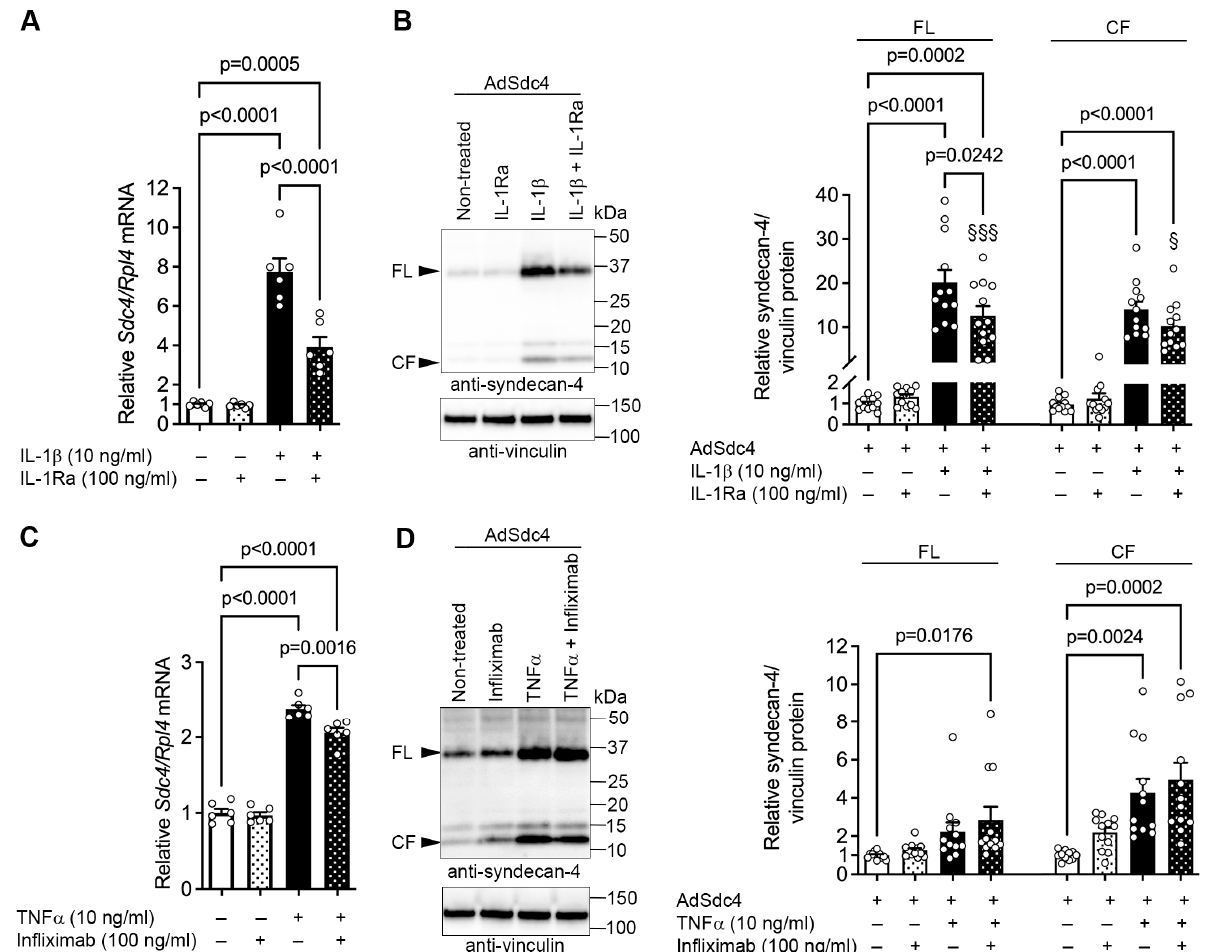
Figure 5. Interleukin 1 β -increased syndecan-4 levels and shedding are attenuated by immunomodu- latory therapy in cultured cardiac fibroblasts. Primary cardiac fibroblast cultures were prepared form neonatal rat hearts. ( A ) Relative mRNA levels of rat syndecan-4 (Sdc4) in cardiac fibroblasts after 24 h treatment with interleukin (IL)-1 β (10 ng/mL) compared to non-treated control or co-treatment with the IL-1 receptor antagonist (IL-1Ra; 100 ng/mL), n = 6. ( B ) Representative immunoblot and quantifi- cation of full-length (FL) syndecan-4 and the cellular fragment (CF) remaining after shedding of the ectodomain, in rat cardiac fibroblasts transduced with an adenovirus encoding mouse syndecan-4 (AdSdc4) and following 24 h treatment with IL-1 β compared to non-treated or co-treatment with IL-1Ra, n = 12. ( C ) Relative mRNA of rat syndecan-4 in cardiac fibroblasts after 24 h treatment with tumor necrosis factor (TNF) α (10 ng/mL) vs. non-treated control or co-treatment with the anti-TNF α antibody infliximab (100 ng/mL), n = 6. ( D ) Representative immunoblot and quantification of syndecan-4 FL and CF in cardiac fibroblasts transduced with mouse AdSdc4 and treated for 24 h with TNF α vs. non-treated or co-treatment with infliximab, n = 12. mRNA data were normalized to ribosomal protein L4 (Rpl4). Vinculin was used for loading control. All data are presented as mean ± S.D. Statistical differences were tested using one-way ANOVA with Tukey’s post hoc test (( A – D ), p -values given) or Student’s unpaired t -test (( B ) § p < 0.05; §§§ p < 0.001, comparing Il-1Ra to IL-1 β alone, not relative to controls). The numerical data supporting the graphs can be found in Supplementary Tables